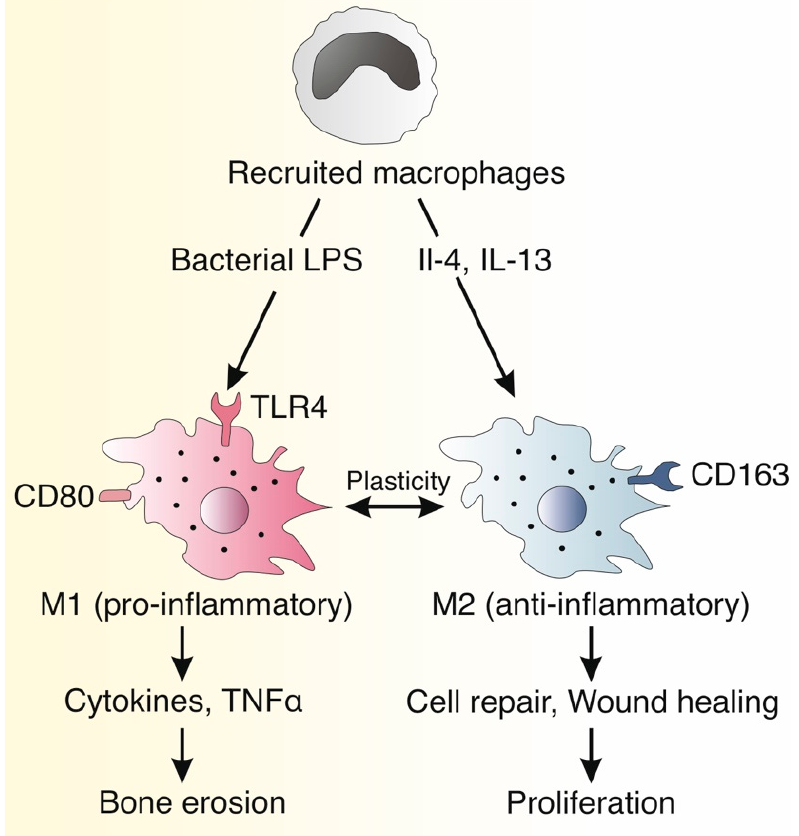
Figure 4. Schematic illustration of the macrophage polarization pathway in middle ear cholesteatoma. Bacterial infection, most commonly with Pseudomonas aeruginosa , is commonly found in cholesteatoma since the entrapped keratin is an ideal environment for bacterial biofilms. Recruited macrophages in the middle ear respond to bacterial lipopolysaccharide (LPS), which binds to Toll-like receptor 4, promoting conversion into the proinflammatory M1 macrophage phenotype. In turn, M1 macrophages produce a myriad of inflammatory cytokines, including tumor necrosis factor alpha (TNF α ), that induce osteoclastic bone erosion. In contrast, interleukin-4 (IL-4) and interleukin-13 (IL-4) promote conversion to the anti-inflammatory M2 phenotype. M2 macrophages secrete a variety of cytokines and growth factors that contribute to homeostasis, wound healing, and cell repair. These growth factors promote proliferation and cell division. The surface proteins CD80 and CD163 mark the M1 and M2 cells, respectively.